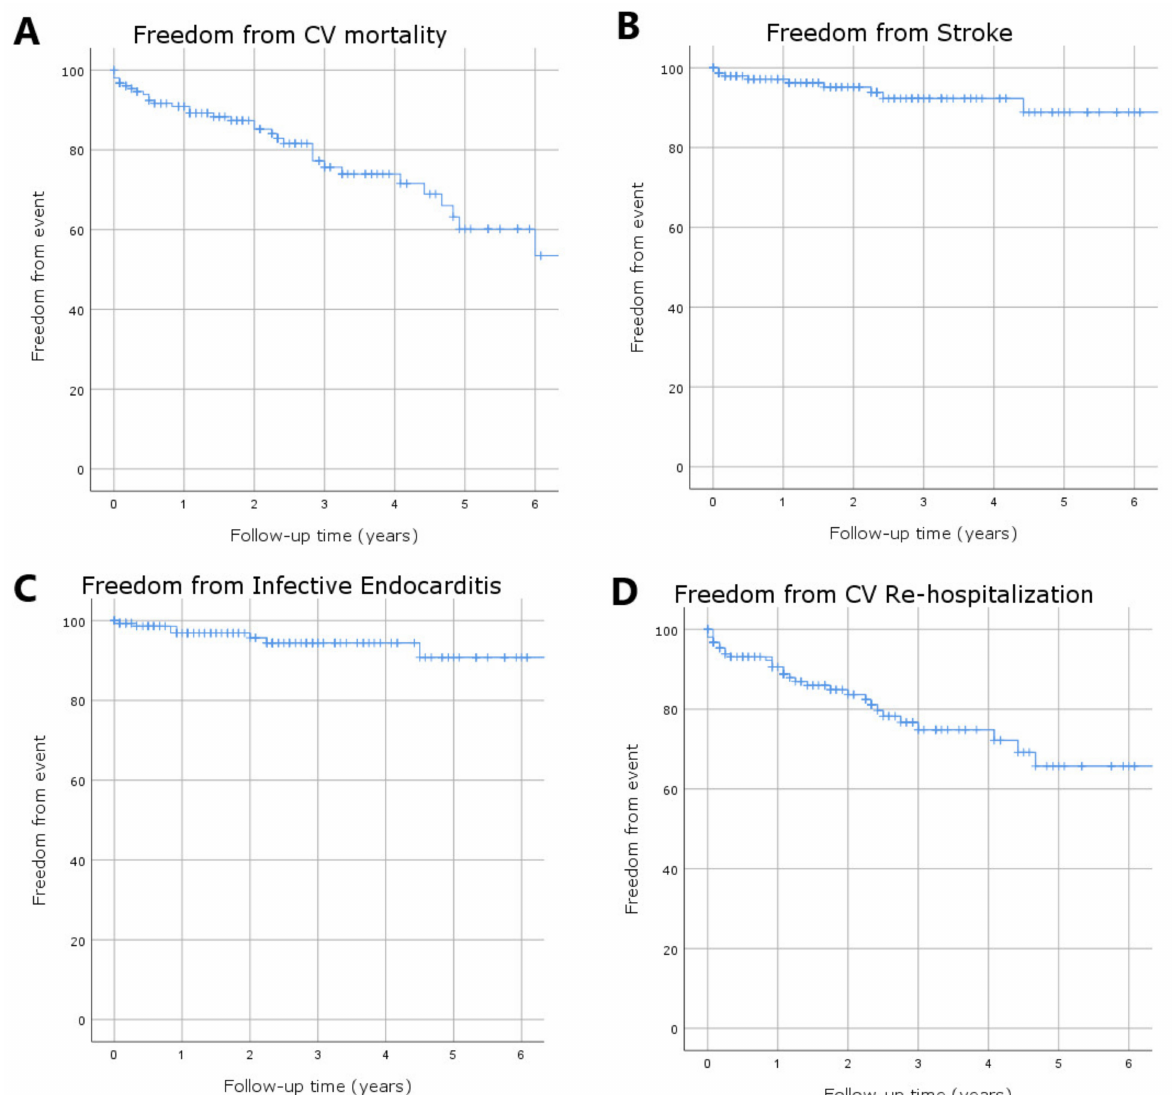
Figure 5. Kaplan–Meier curves estimated for freedom from major clinical events at mid-term follow- up: ( A ) freedom from cardiovascular (CV) mortality; ( B ) freedom from stroke; ( C ) freedom from endocarditis; and ( D ) freedom from re-hospitalization due to CV